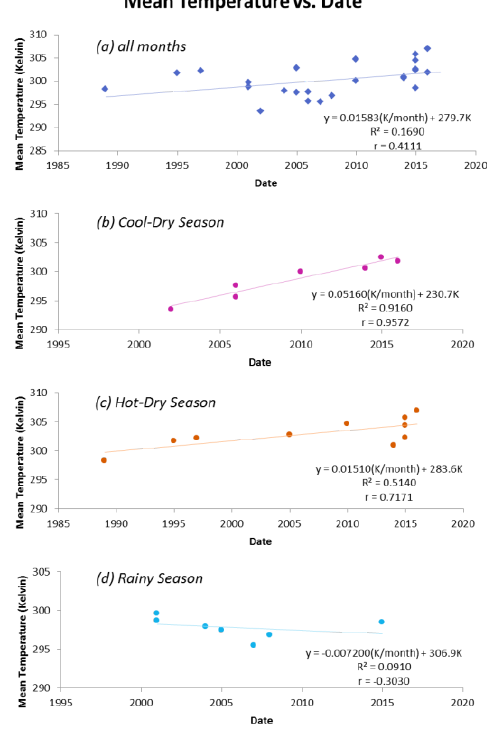
Figure 5. Seasonal trends in the mean UHI temperature.